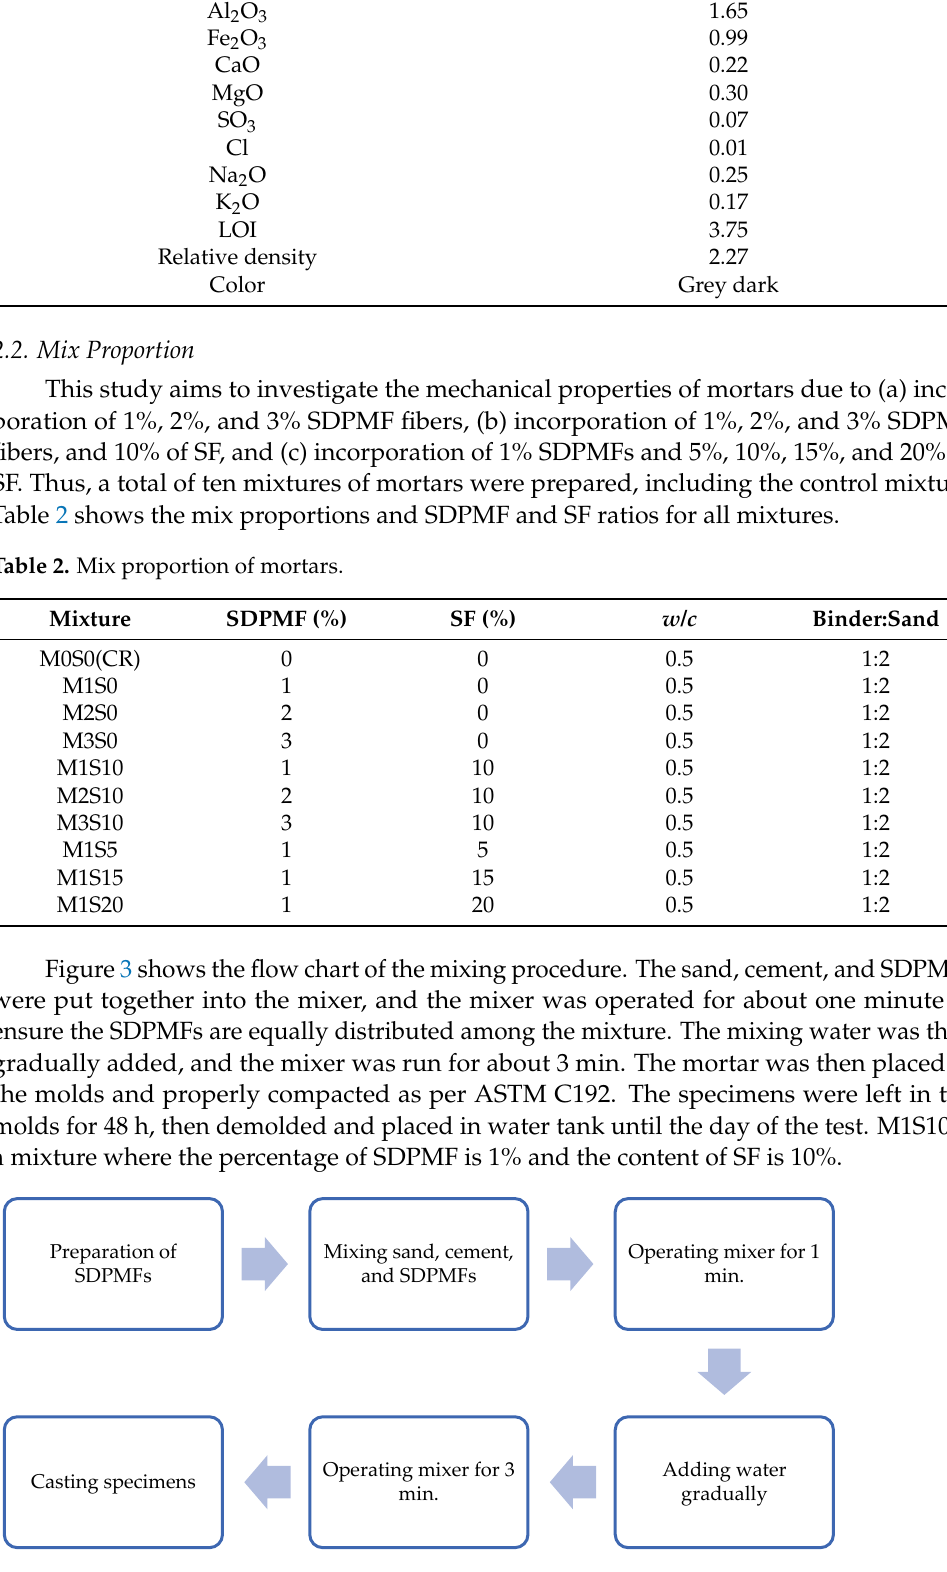
Figure 3. Mortars mixing procedure.